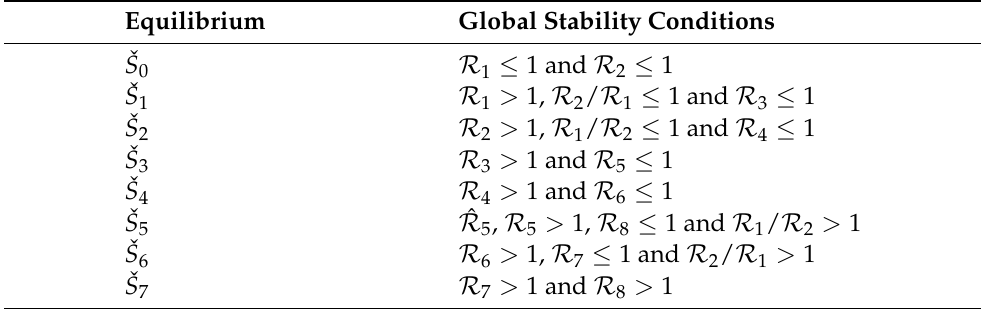
Table 1. Global stability conditions for the equilibria of Model (4).